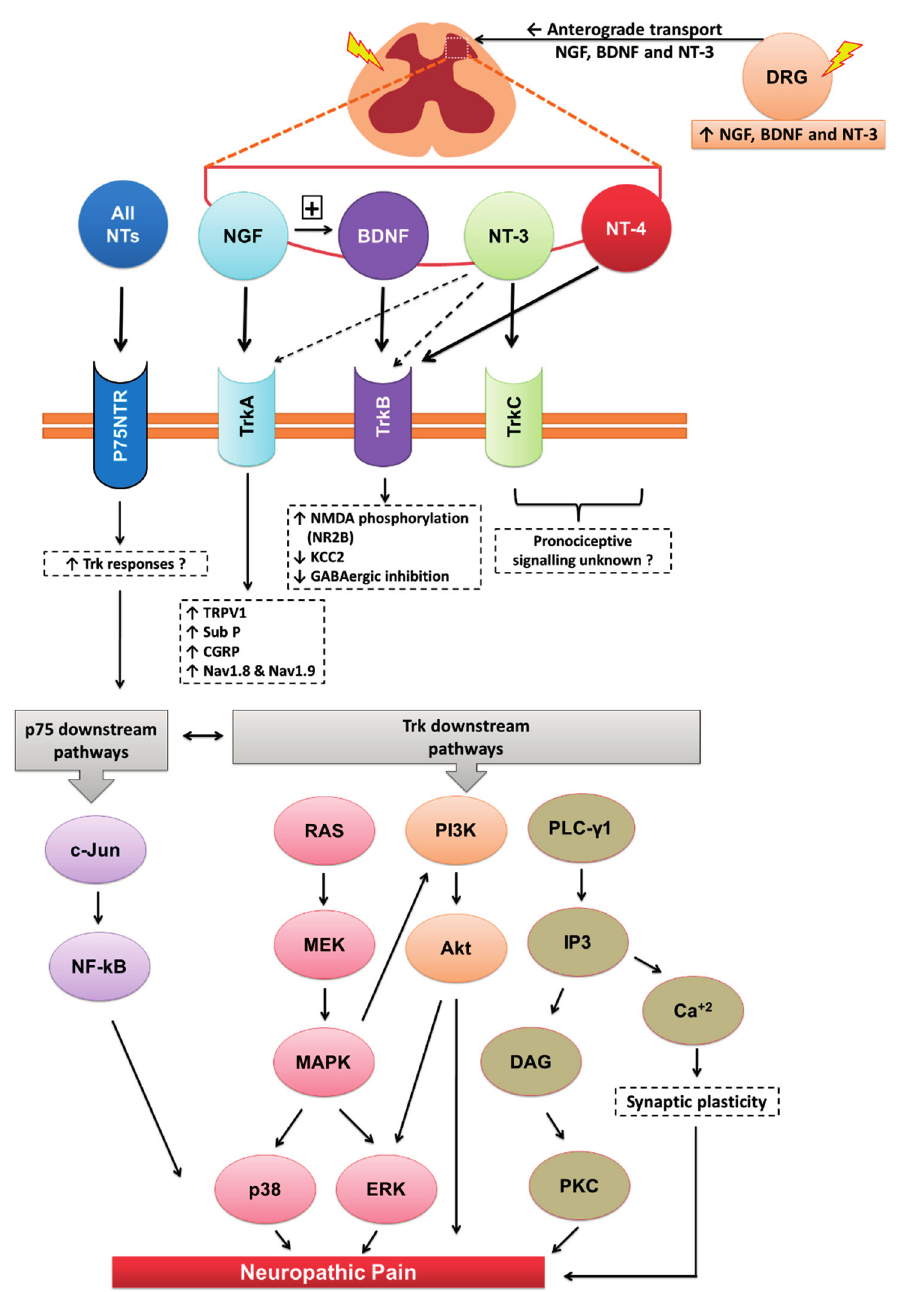
Figure 2. Downstream signalling of neurotrophins and their receptors. Akt, Akt kinase; Ca+2, calcium ions; CGRP, calcitonin gene related peptide; DAG, diacylglycerol; DRG, dorsal root ganglia; ERK, extracellular-signal-regulated kinase; GABA, γ -Aminobutyric acid; IP3, inositol tris-phosphate; KCC2, potassium chloride cotransporter 2; MAPK, mitogen-activated protein kinases; MEK, mitogen-activated protein kinase/ERK kinase; Nav, sodium-ion voltage-gated channel; NMDA, N -methyl- D -aspartate; NT, neurotrophin; p75NTR, pan neurotrophin receptor at 75kDa; PI3K, phosphatidylinositol 3-kinase; PLC- γ 1, phospholipase C-gamma-1; Ras, small GTP-binding protein; Sub-P, substance-P; Trk, tyrosine kinase receptor; TRPV1, transient receptor potential cation channel subfamily V member